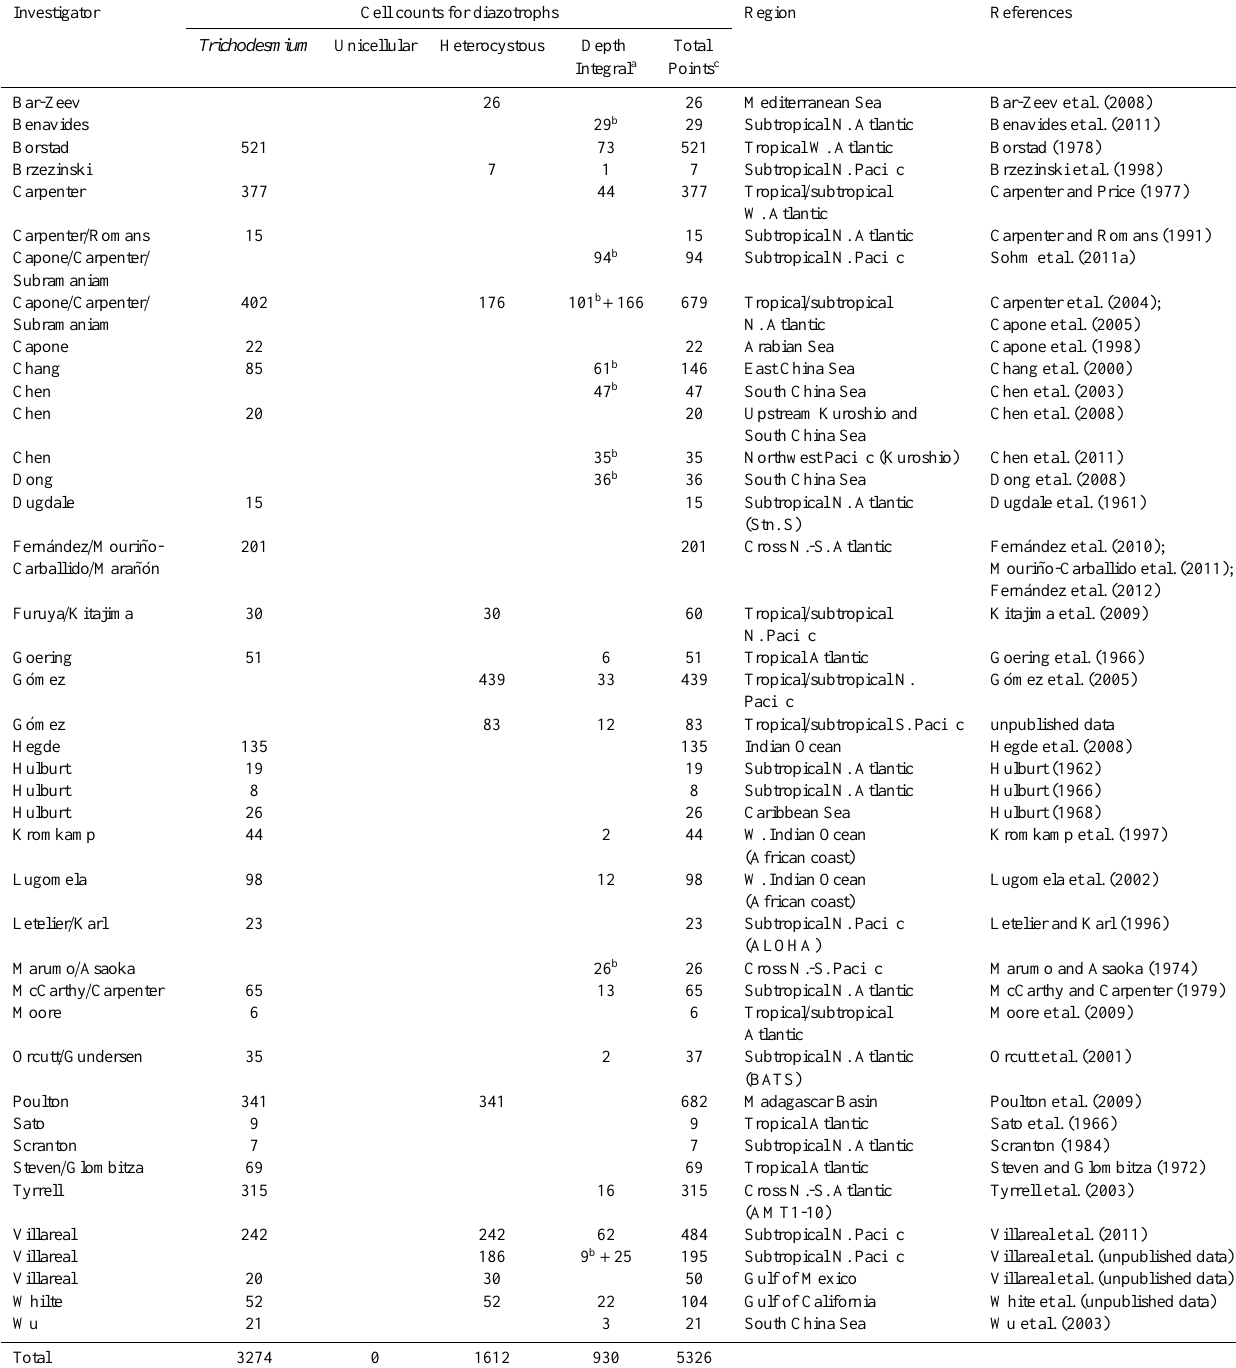
Table 1a. Summary of data points for cell counts of diazotrophs, including volumetric measurements of Trichodesmium , unicellular cyanobacteria and heterocystous cyanobacteria and their